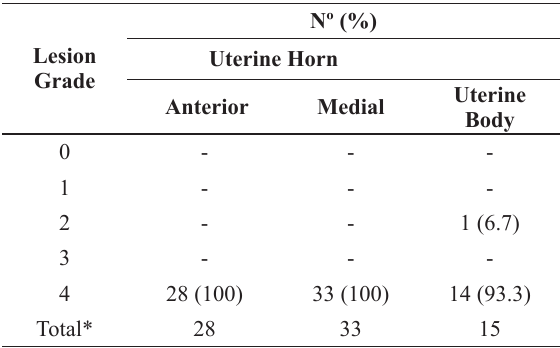
Distribution of microscopic lesions in the uterus (uterine horns and body) of heifers with GVS and presenting positive culture for Ureaplasma diversum.